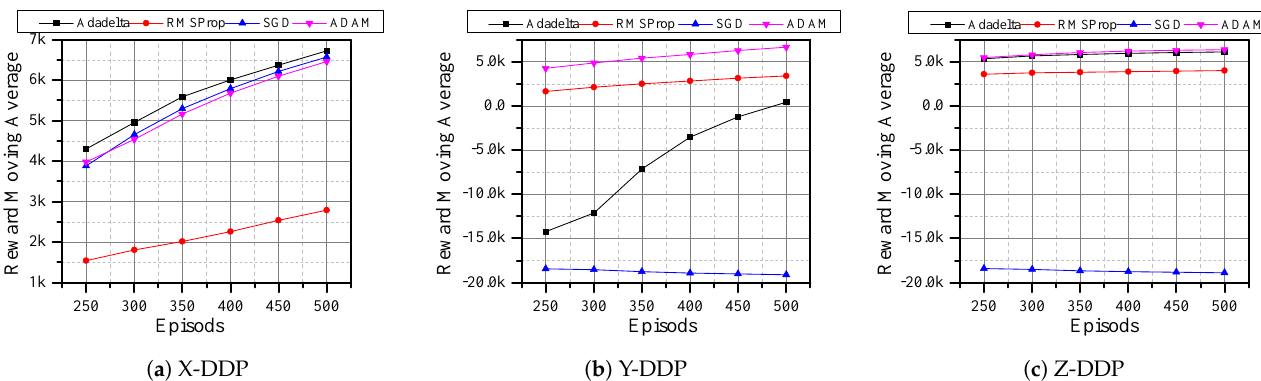
Figure 5. Learning algorithms with 100 steps/episode for a total of 1000 episodes using the Euclidean distance reward function.